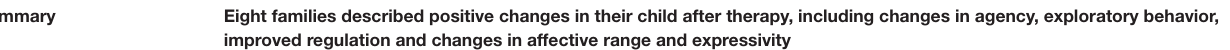
Main theme: Perceived changes in behaviors related to self-agency and